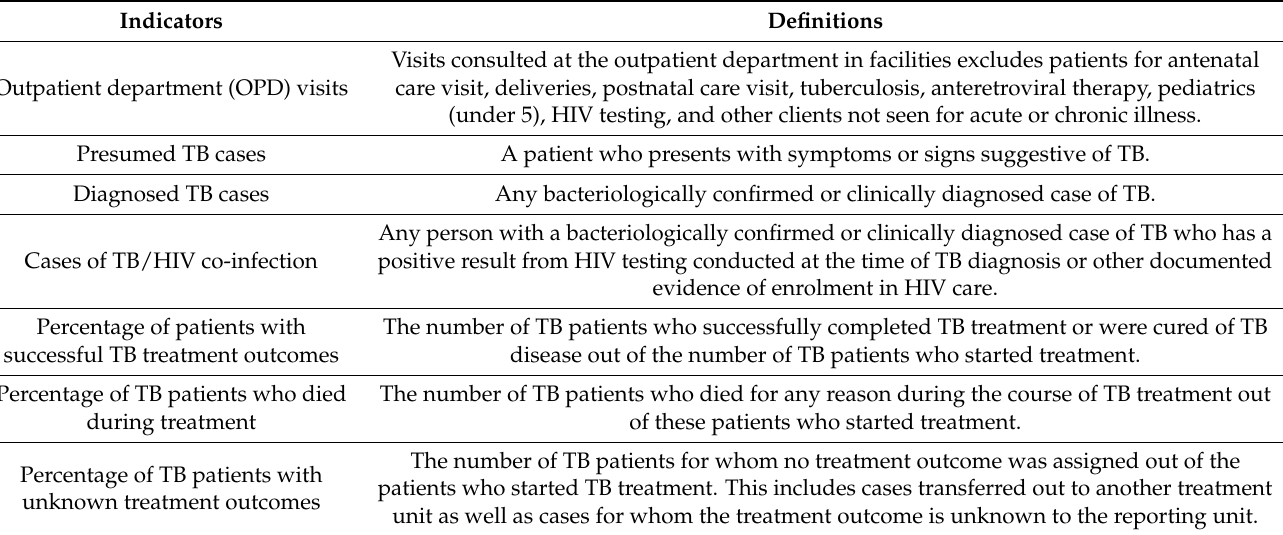
Table 1. Selected indicator